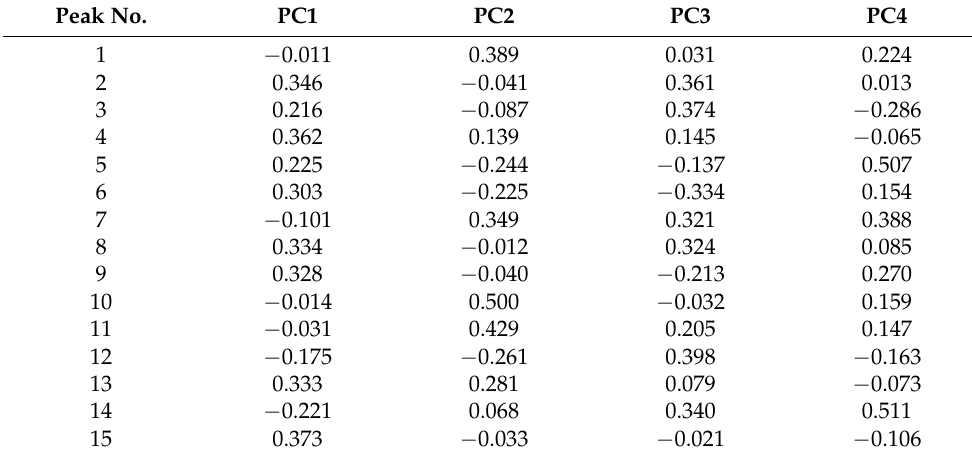
Table 4. Principal component factor load matrix of Echinacea pupurea (L.) Moench. Peak No. PC1 PC2